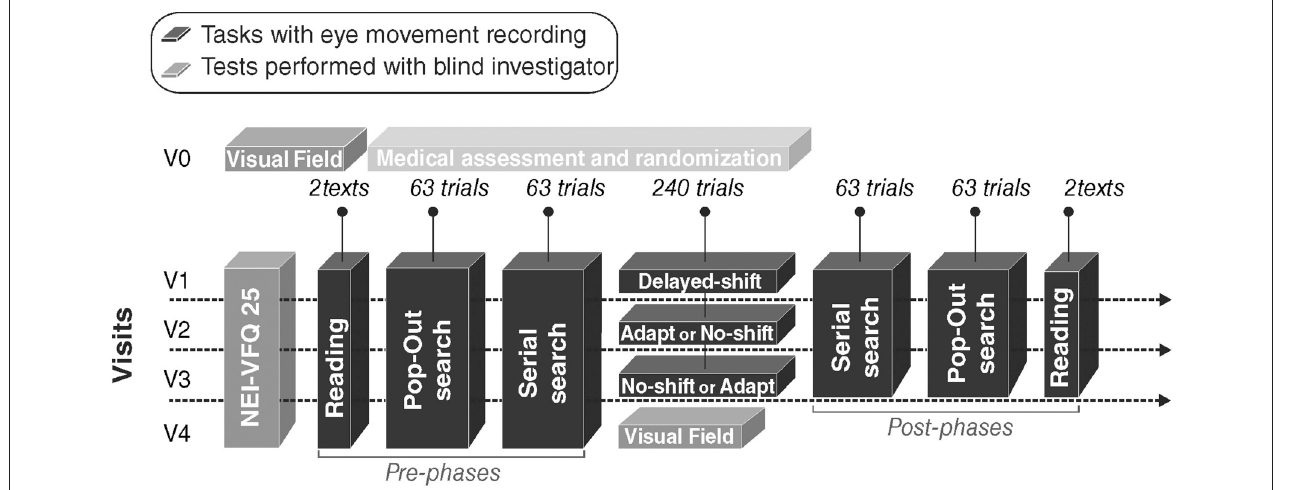
FIGURE 2 | Study design. Each patient came first for an inclusion visit (V0) and then four times: three visits with a training (V1, V2, and V3) plus a follow-up visit (V4). V1 occurred 1–6 weeks after V0 and an interval of 4 or 5 weeks spanned between each of the four following visits. Black blocks correspond to the eye movements recording tasks. Gray blocks correspond to tests performed with a blind investigator. Light gray block corresponds to the medical assessment and the randomization of training.